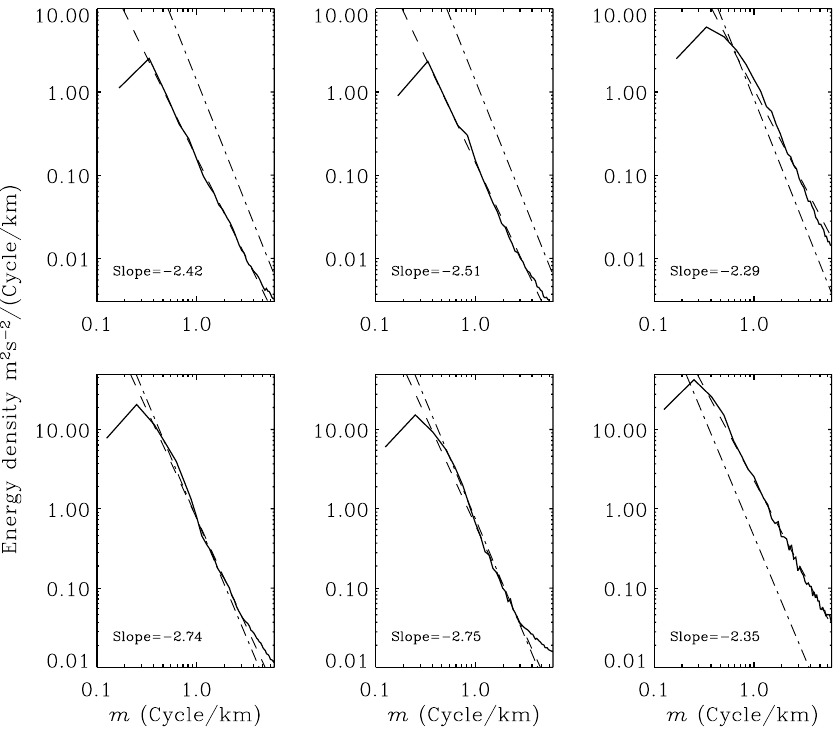
Fig. 9. Similar to Fig. 5, but for GWs in January